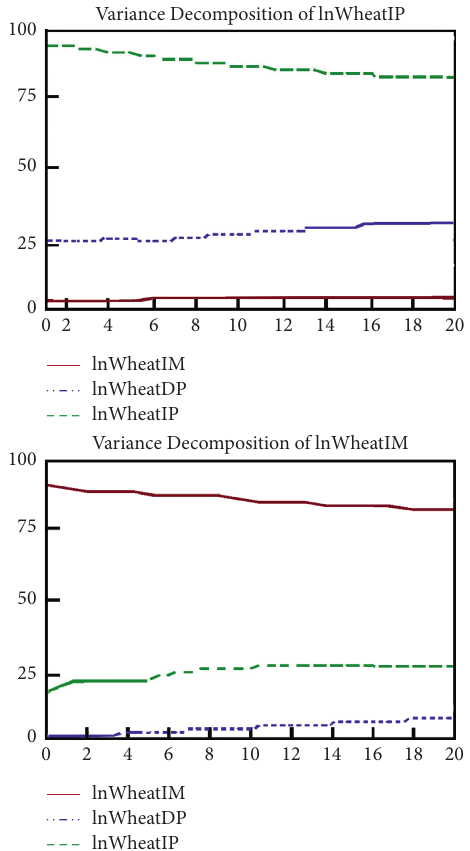
Figure 10: Variance decomposition analysis results for